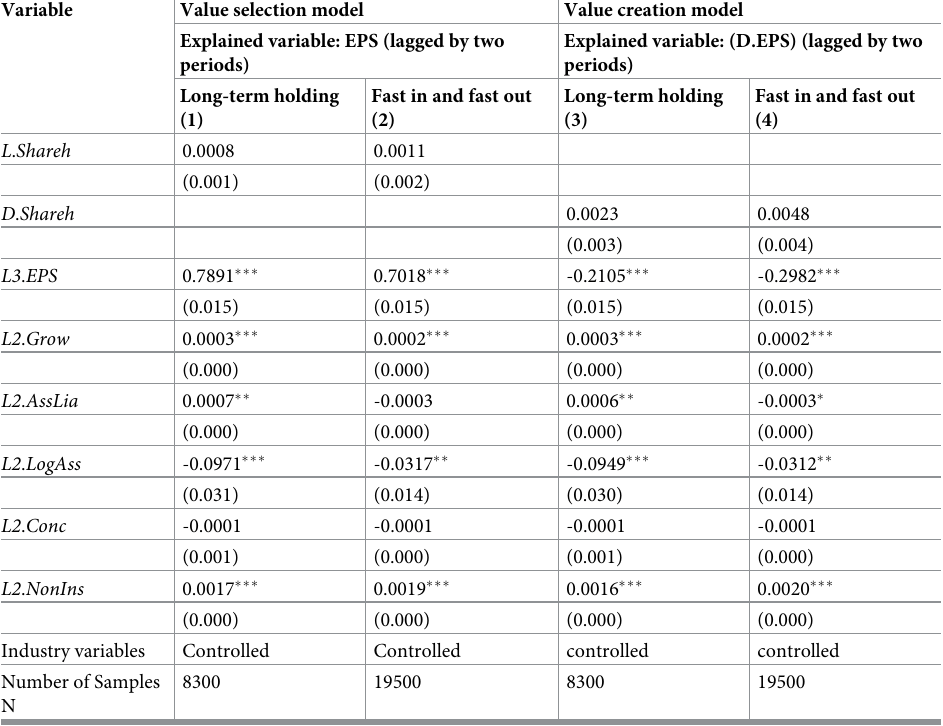
Table 6. Counterfactual test model parameter estimation